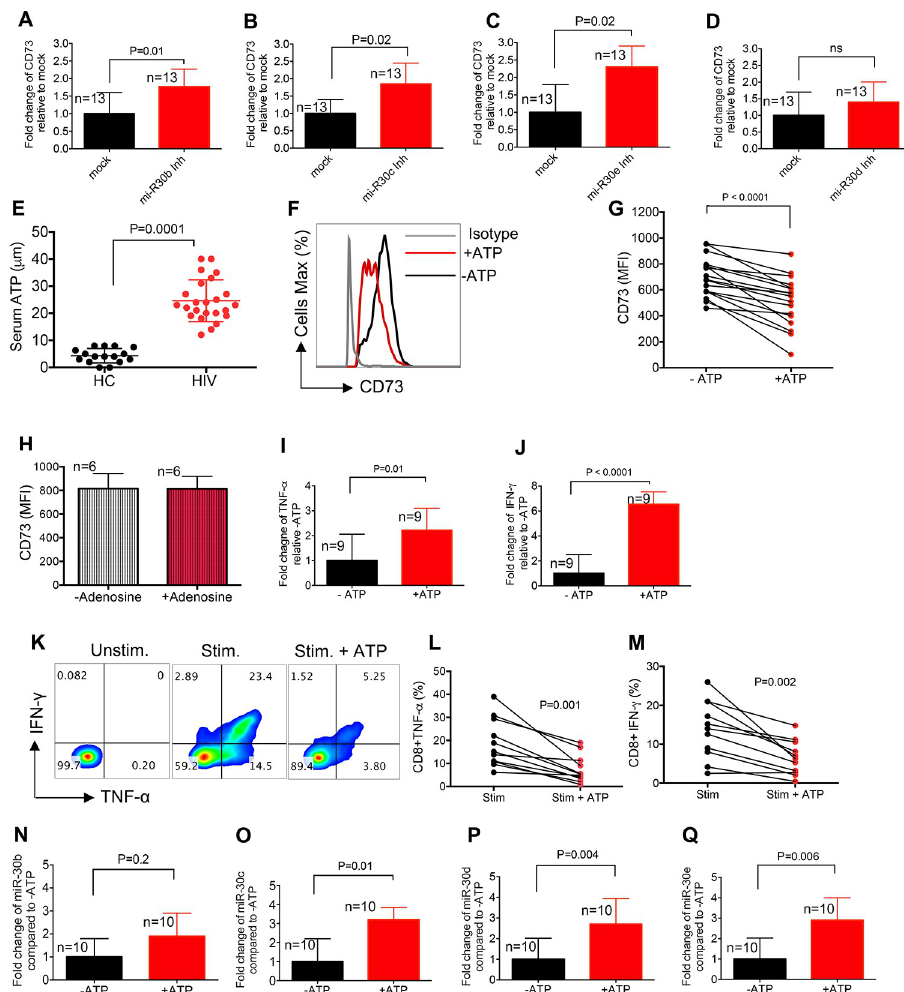
adenosine (10 μ M) for 72 hr. ( I ) Fold change of TNF- α , and ( J ) IFN- γ genes in CD8 + T cells treated with or without ATP (25 μ M) for 72 hr. ( K ) Representative flow cytometry plots, and ( L ) cumulative data for TNF- α , and ( M ) IFN- γ expression in CD8 + T cells stimulated (stim) with anti-CD3/CD28 antibodies overnight without or with ATP (25 μ M). Unstimulated (Unstim) as negative control. ( N ) Fold change of miR-30b, ( O ) miR-30c, ( P ) miR-30d, and ( Q )